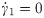
Analytical resolution of the two cells model, properties of the solution in the parameters space αa × αs; a) delimitation of the two zones γ˙1=0 and γ˙1>0: the red thick solid line αs(αa)=1-ρ1-αa corresponds to ρ = 0.75. The two black thin dashed lines correspond to the values ρ = 0.5 and 0.99. b-c) Turgors P0 and P1 for ρ = 0.75. d-e) relative growth rates γ˙i/γ˙i* for ρ = 0.75.